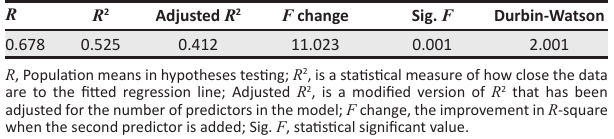
TABLE 9: Summary of the model for hypothesis